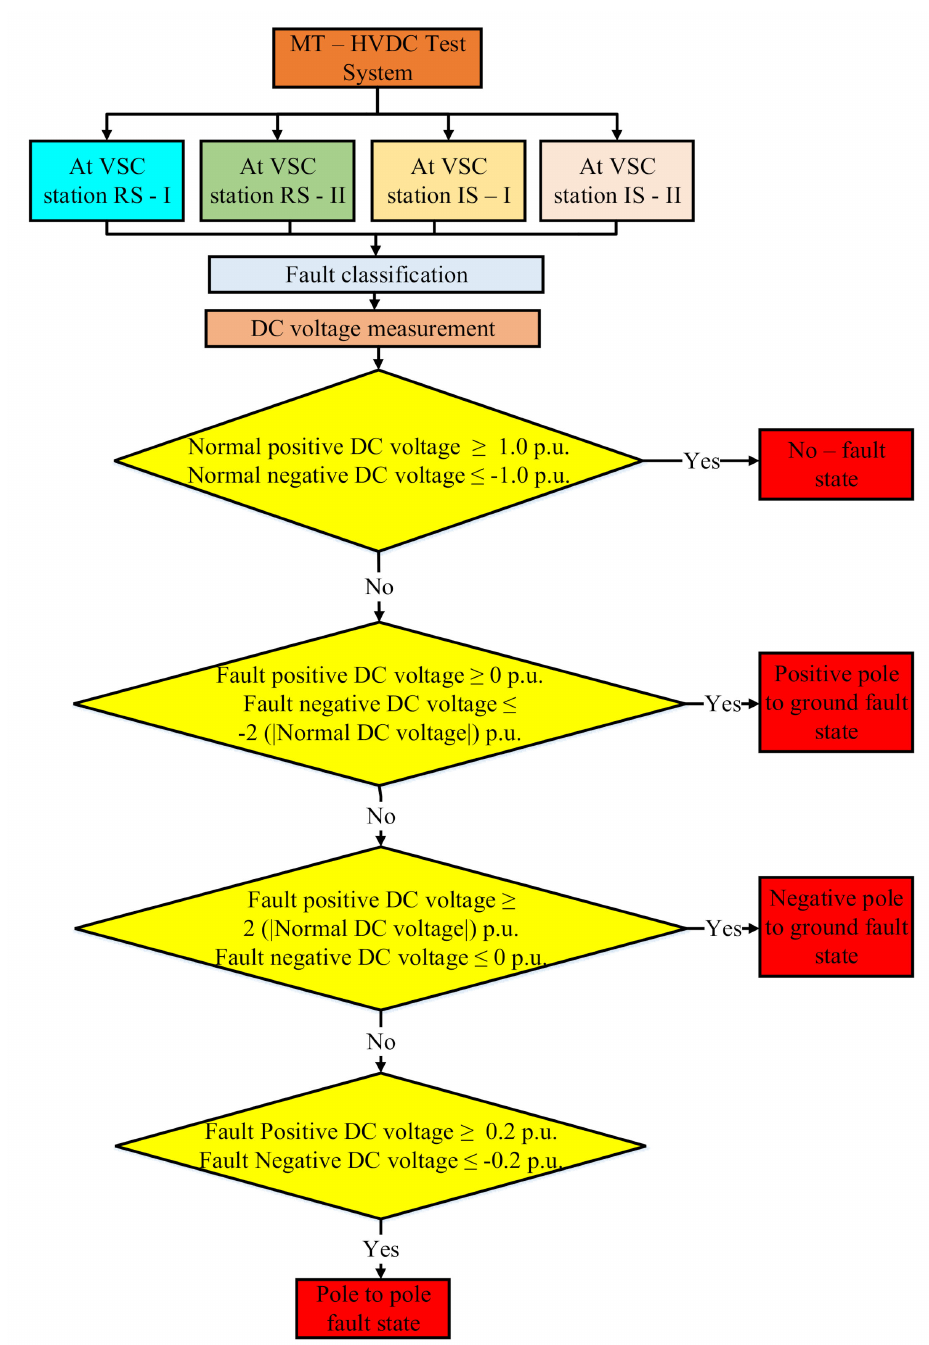
Figure 27. Fault classification scheme based on the DC voltage in the MT-HVDC test